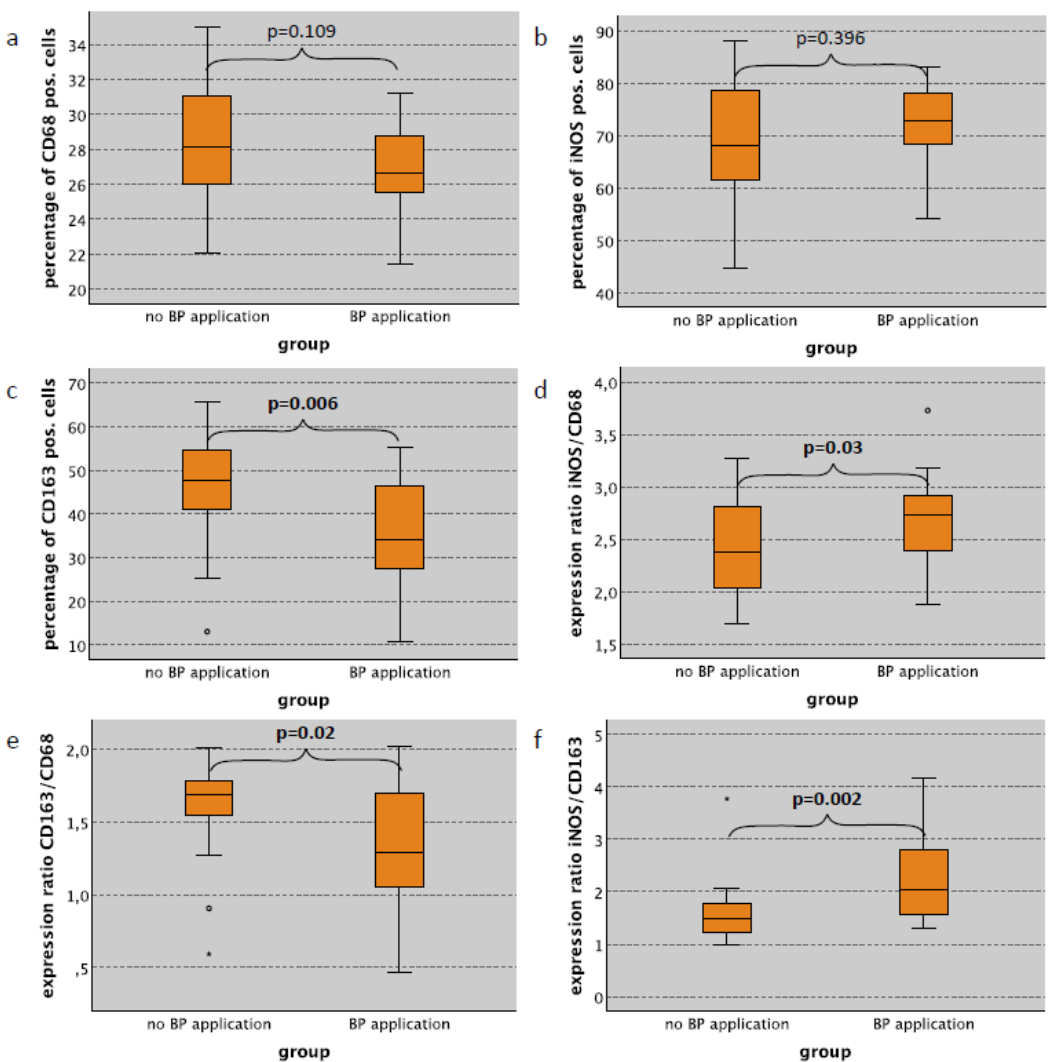
Figure 3. Influence of bisphosphonate application on macrophage infiltration and polarization in spleen red pulp tissue without surgical trauma. Expression of macrophage markers and the correlation to the BP application in the spleen red pulp of rats without surgical trauma. ( a ) Percentage of CD68 pos. cells (pos. cells/all cells in %). ( b ) Percentage of iNOS pos. cells (pos. cells/all cells in %). ( c ) Percentage of CD163 pos. cells (pos. cells/all cells in %). ( d ) Expression ratio of iNOS and CD68 ((iNOS pos./all cells)/(CD68 pos./all cells)). ( e ) Expression ratio of CD163 and CD68 ((CD163 pos./all cells)/(CD68 pos./all cells)). ( f ) Expression ratio of iNOS and CD163 ((iNOS pos./all cells)/(CD163 pos./all cells)). Significant p -values ( p < 0.05) are indicated in bold letters. For statistical analysis, the Mann-Whitney-U-Test was used. * p <